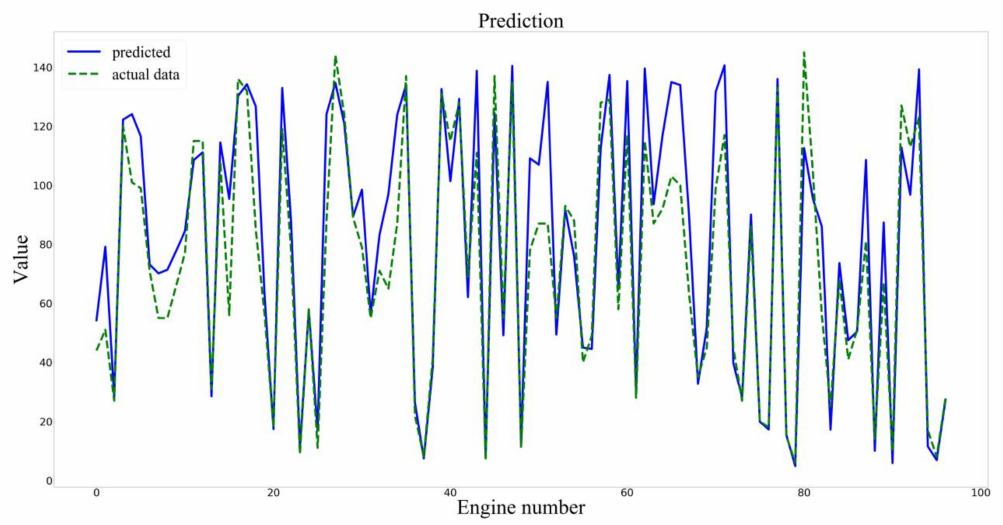
Figure 9. Prediction results of the BLSTM